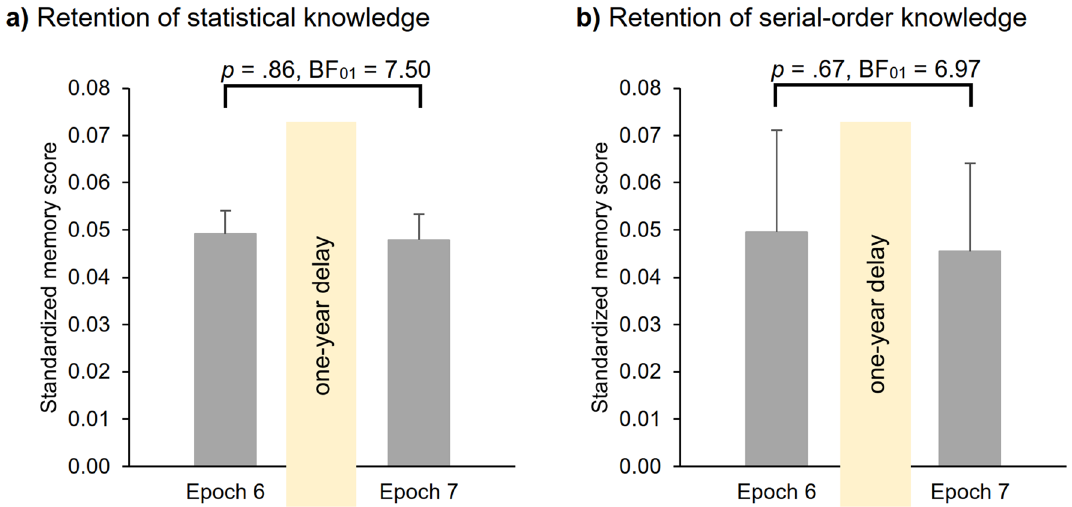
Figure 3. Retention of ( a ) statistical and ( b ) serial-order knowledge. Memory scores measured by standardized RT values for the last epoch of the Testing Phase (Epoch 6) and the first epoch of the Retesting Phase (Epoch 7). Error bars denote the standard error of